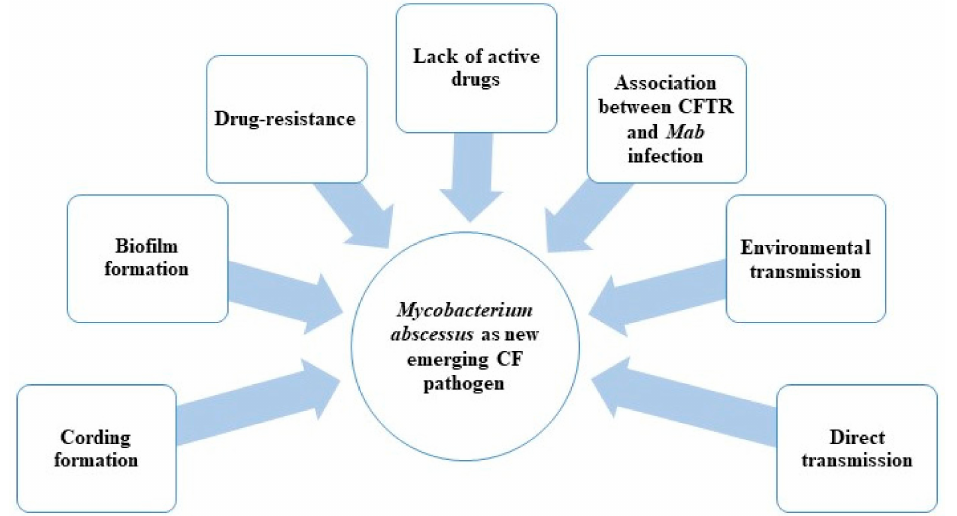
Figure 1. Factors contributing to the spread of M. abscessus ( Mab ) as an emerging pathogen among cystic fibrosis (CF) patients. CFTR: cystic fibrosis transmembrane conductance